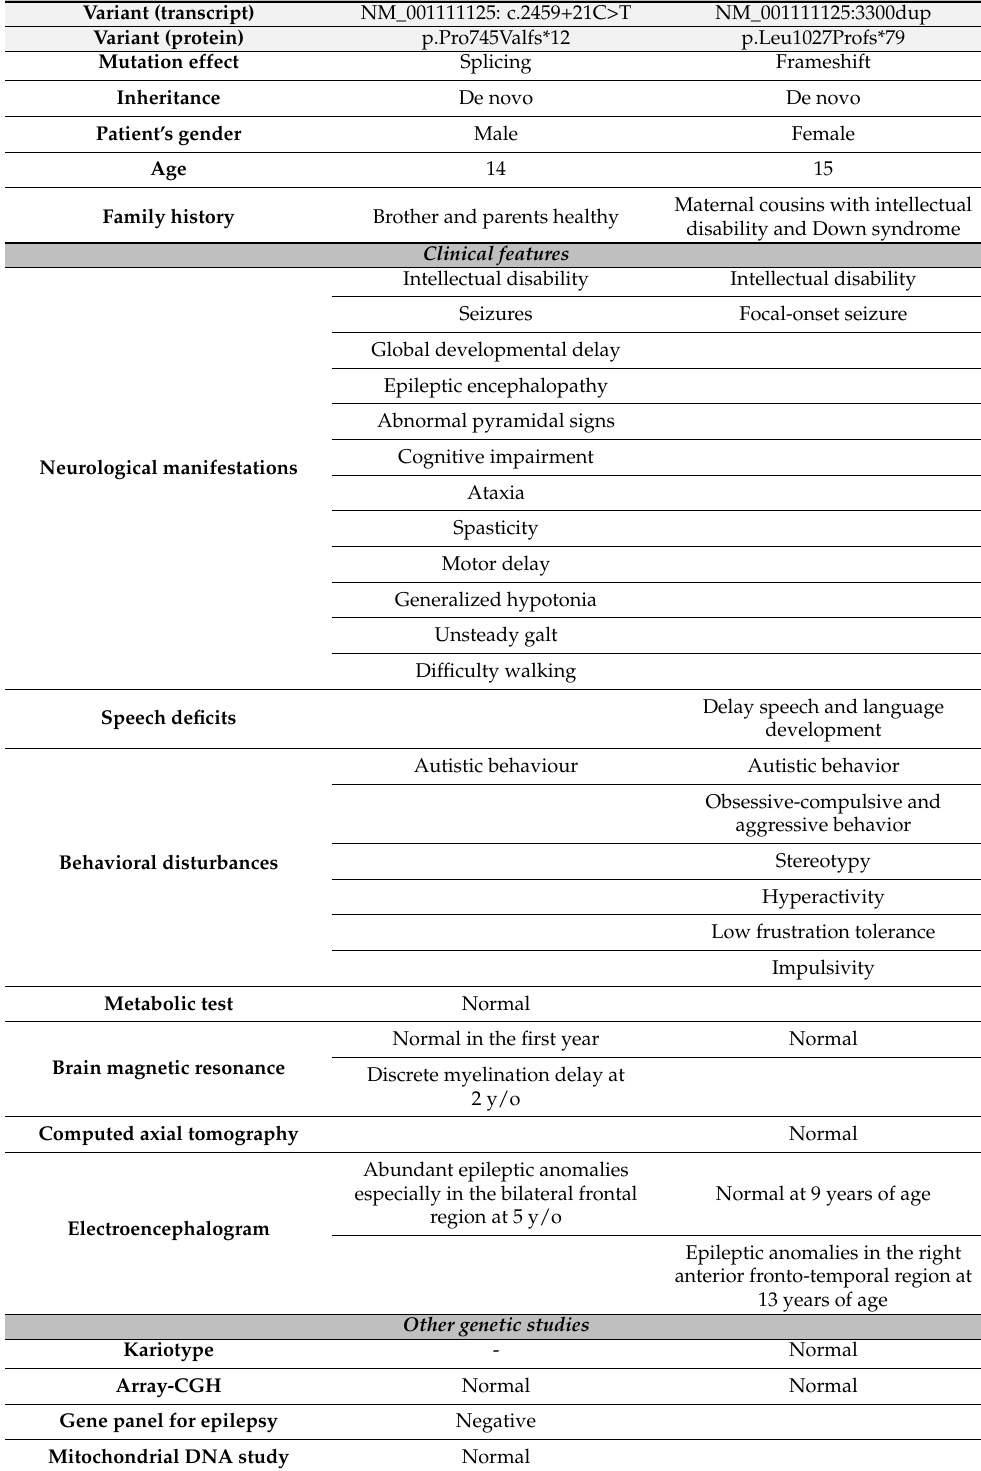
Table 1. Description of clinical characteristics of the